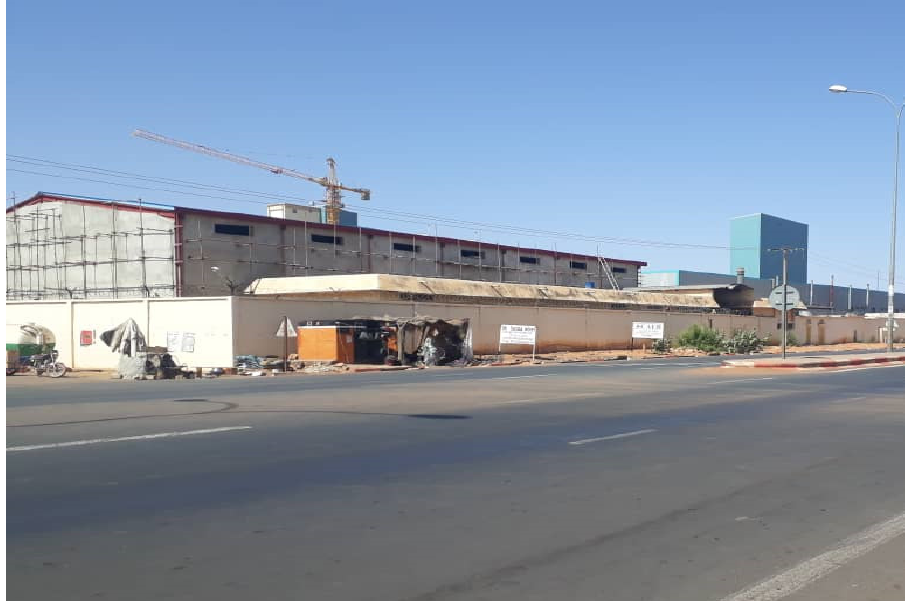
Figure 2. Food processing plant (Grand Distributeur Céréalier du Mali) located on the farmland of Sebougou.